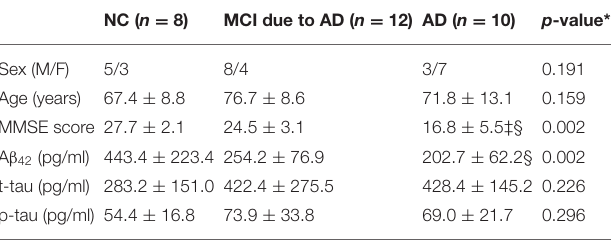
TABLE 2 | Characteristics of participants included in the CSF